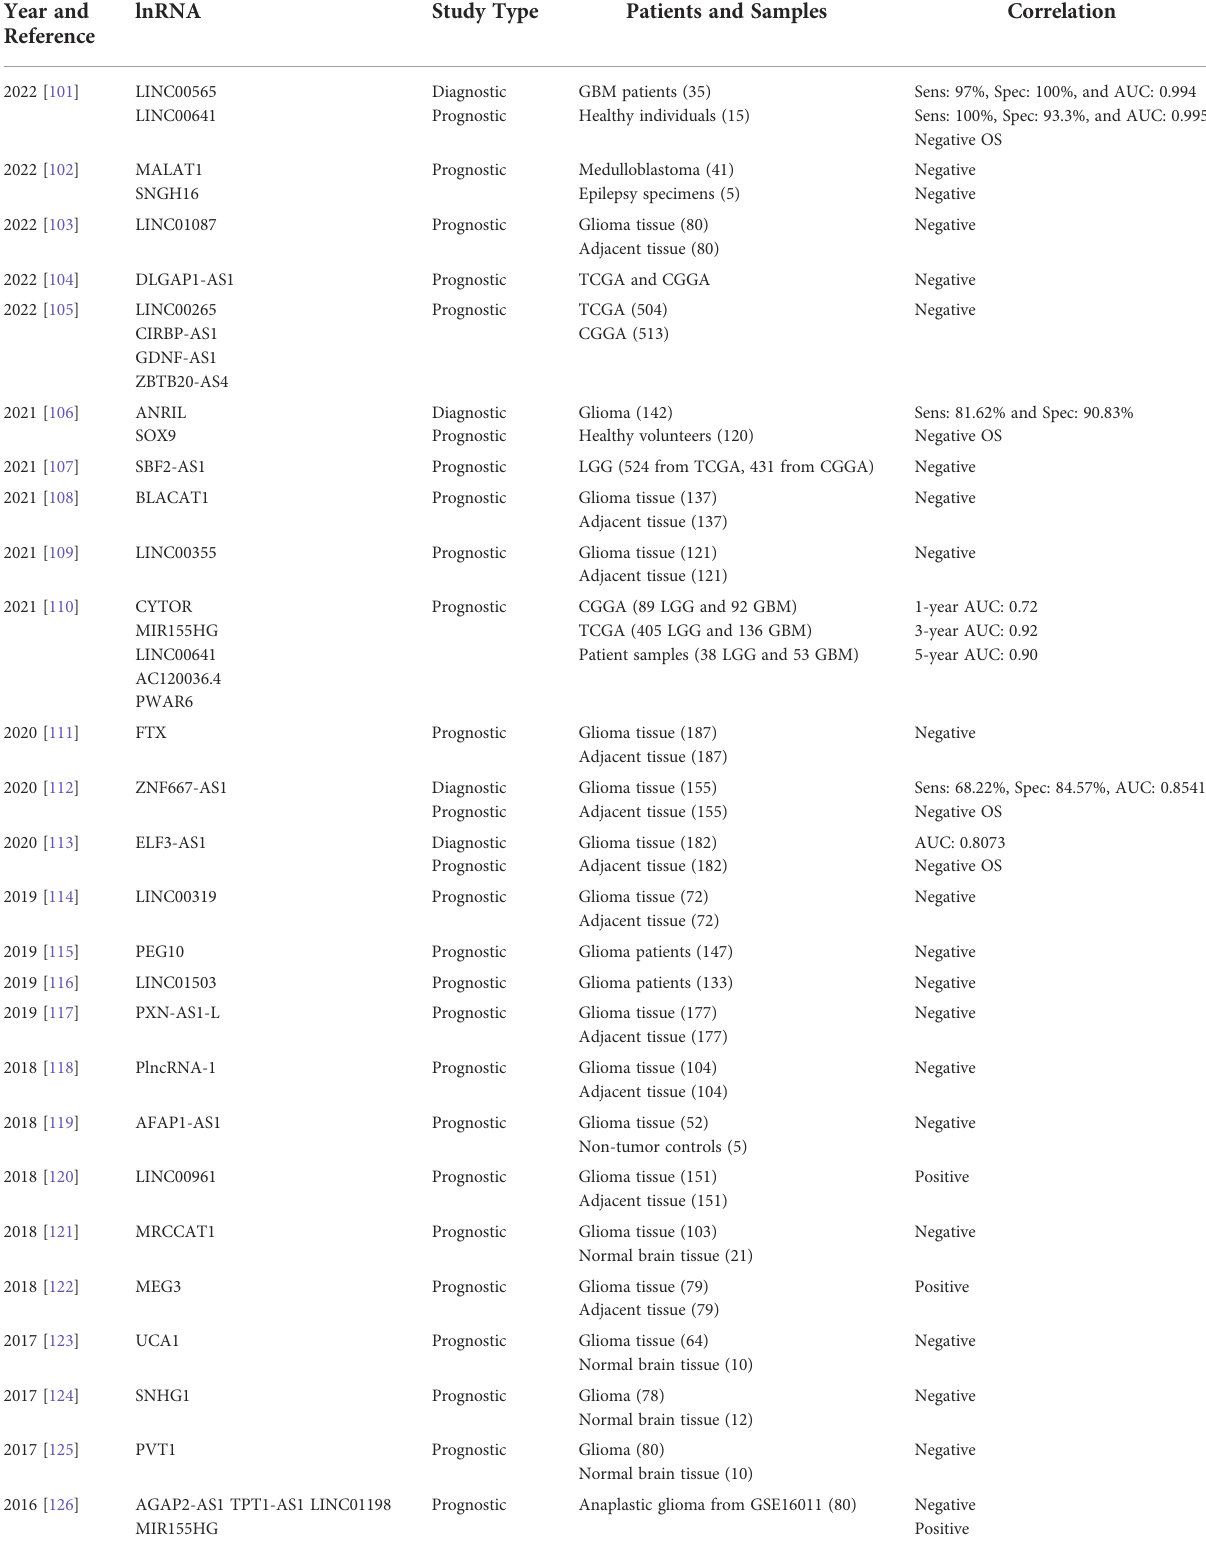
TABLE 2 Table summarizing the details of recent relevant studies on lnRNAs as diagnostic and/or prognostic biomarkers in